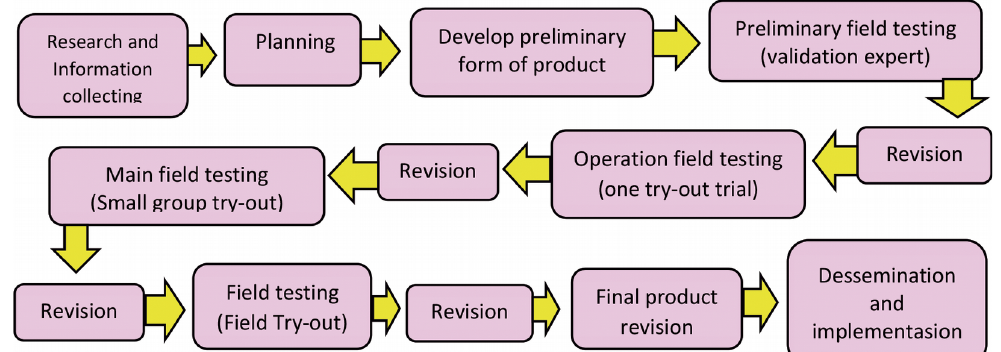
Figure 4. Flow chart Dick and Carey Model use to Design